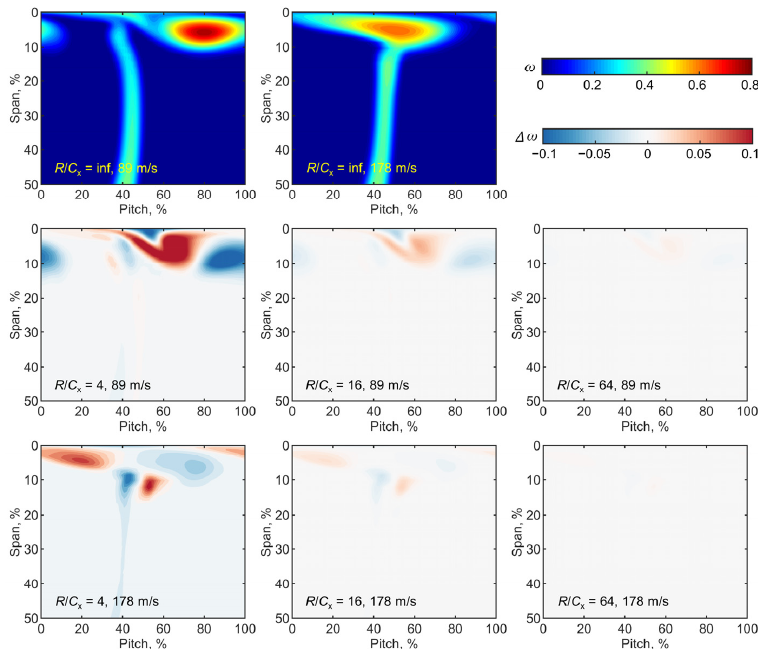
Figure 12. Total pressure loss coefficient and its difference at various disk